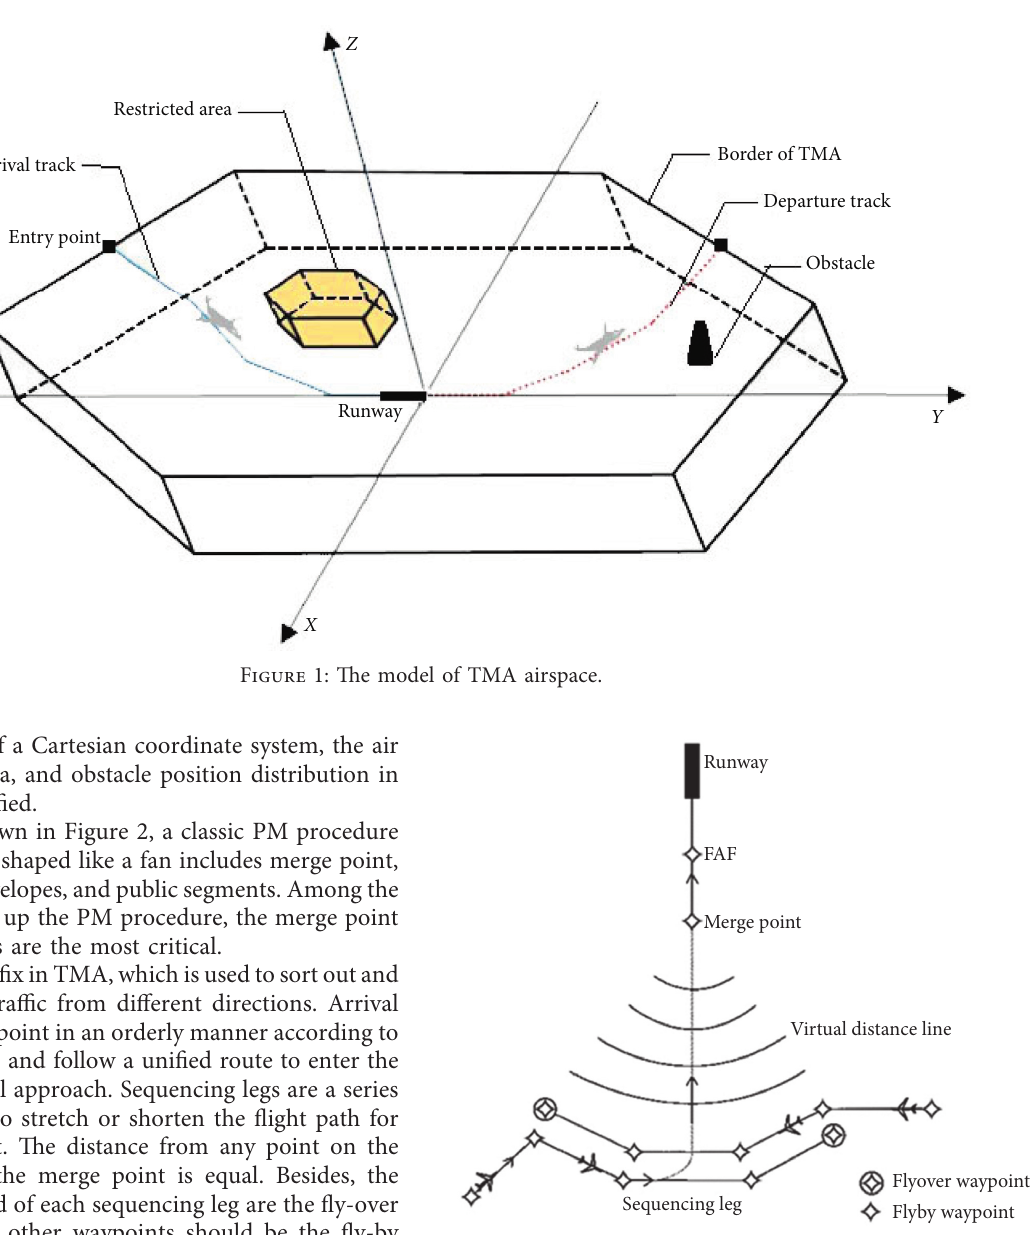
Figure 2: Classic PM